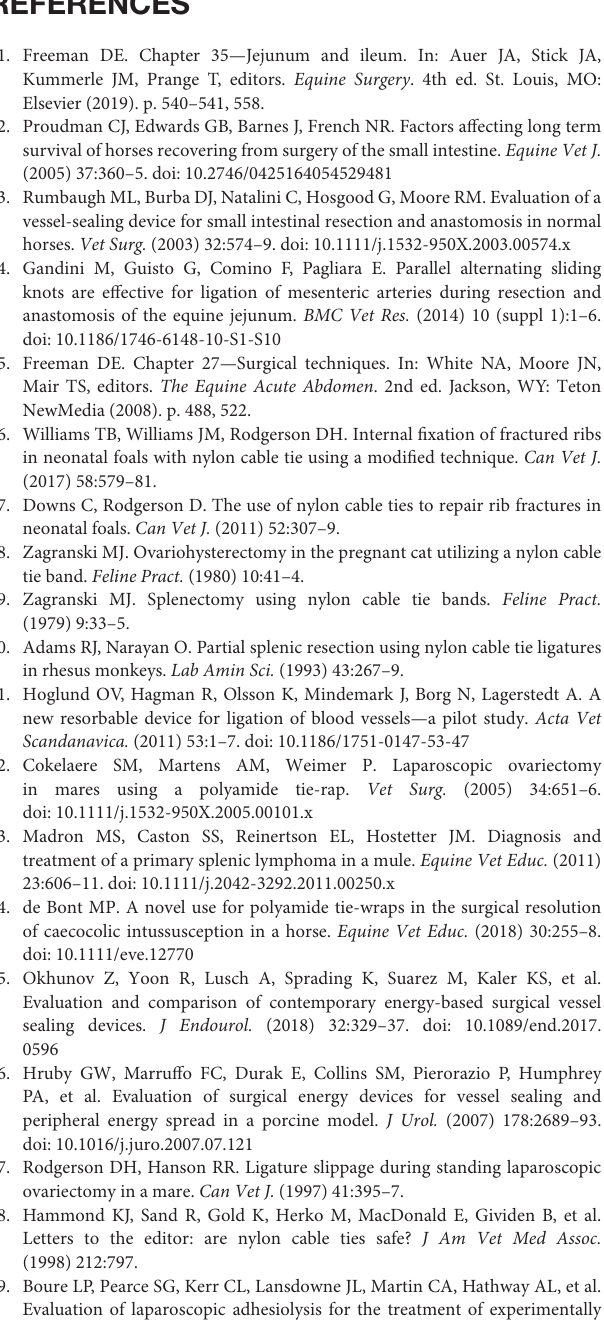
Supplementary File 3 | Placement of Ochsner forcep and transection of the jejunal